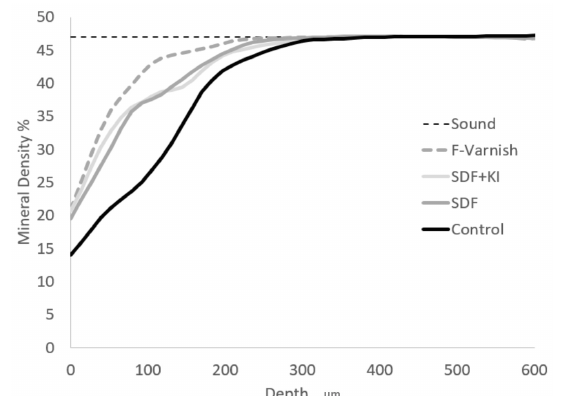
Figure 2. Micro CT mineral density vs. depth profile of representative specimens for all groups. Lesion depth (LD) represents the depth aspect from surface up to where the mineral density is within 5% of the sound tissue (48% in dentin). Mineral loss ( Δ Z) represents the area over the curve for each mineral density profile.